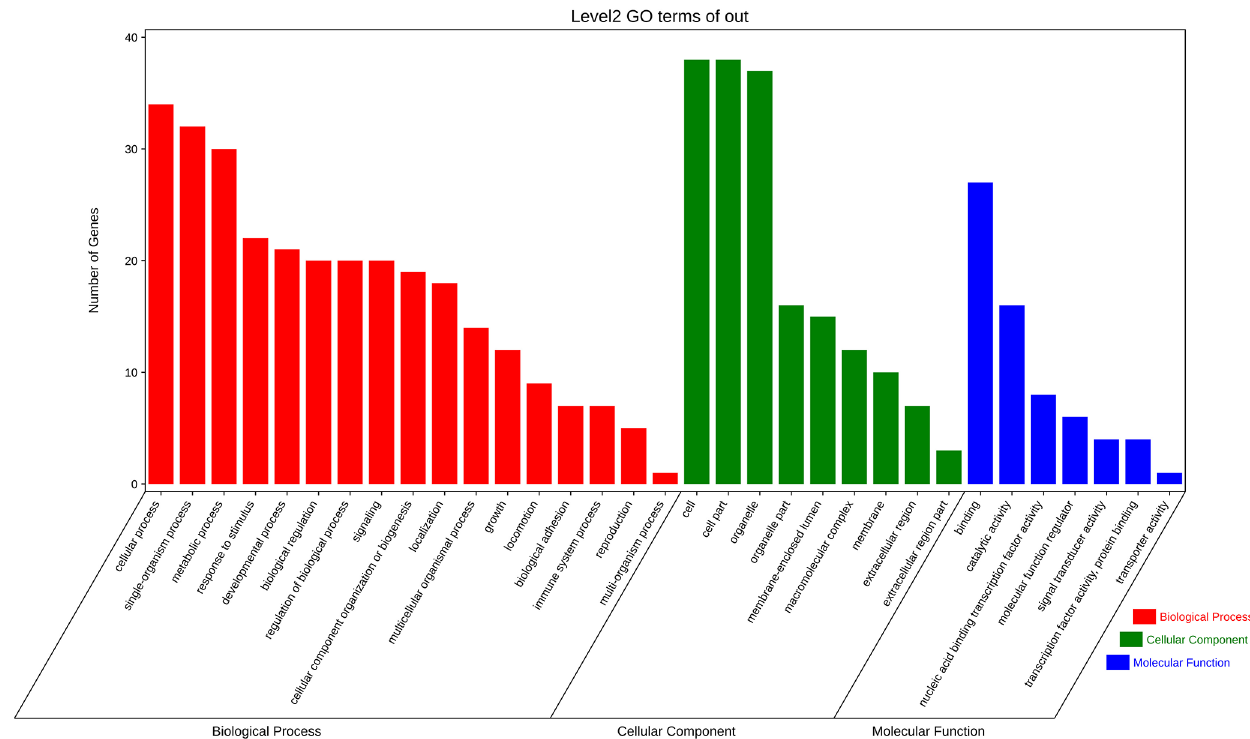
Figure 5. All the target genes were analyzed using taxonomic annotation and enrichment analysis in terms of molecular function, biological process, and cell